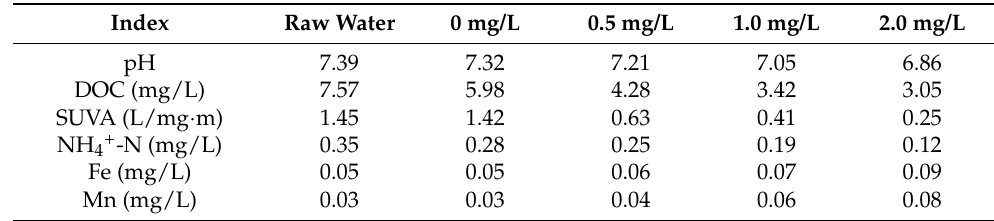
Table 1. Variation in each index in the combined process under different ozone concentration